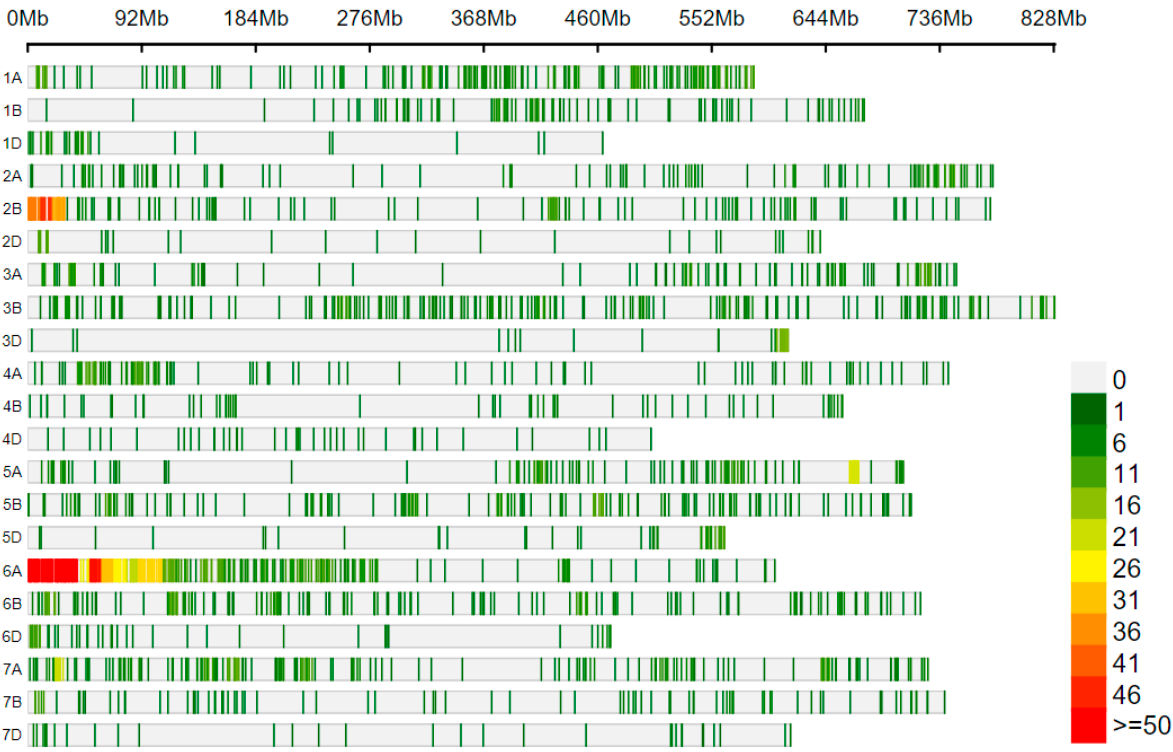
Figure 5. Distribution of SNPs on each chromosome between A303 and Wan7107.